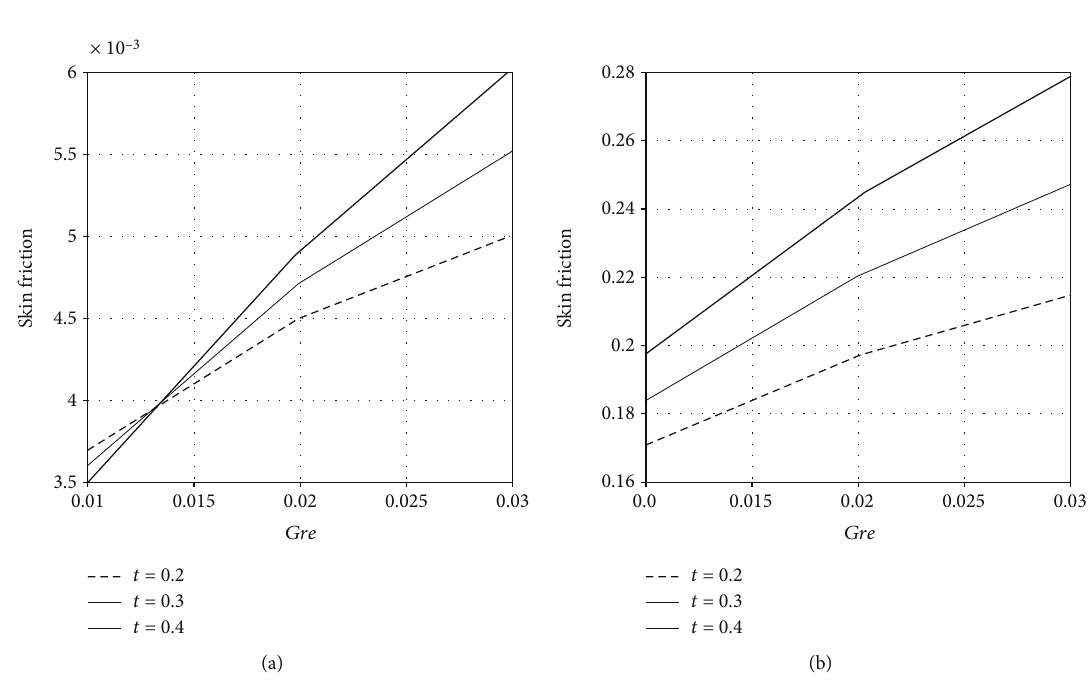
Figure 8: Skin friction for Gre in proportion to t .